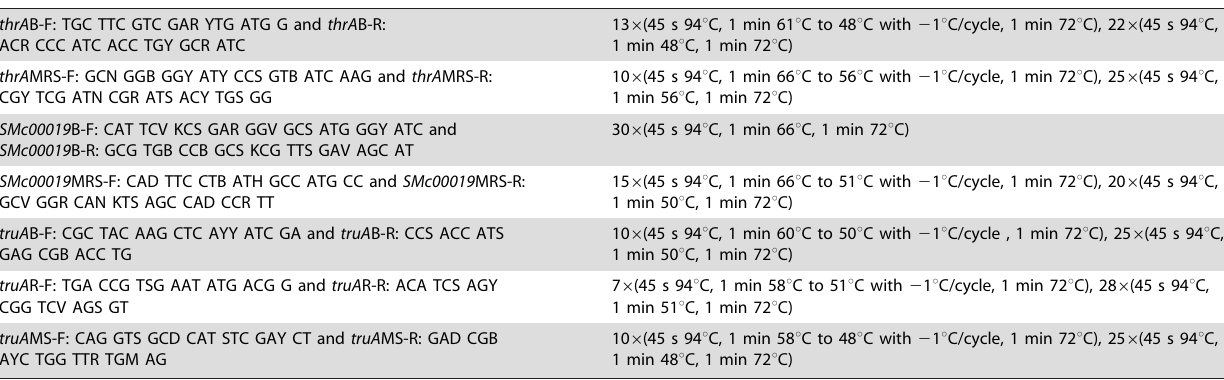
Primer pair: sequence (5 9 -3 9 ) Customized intermediate PCR